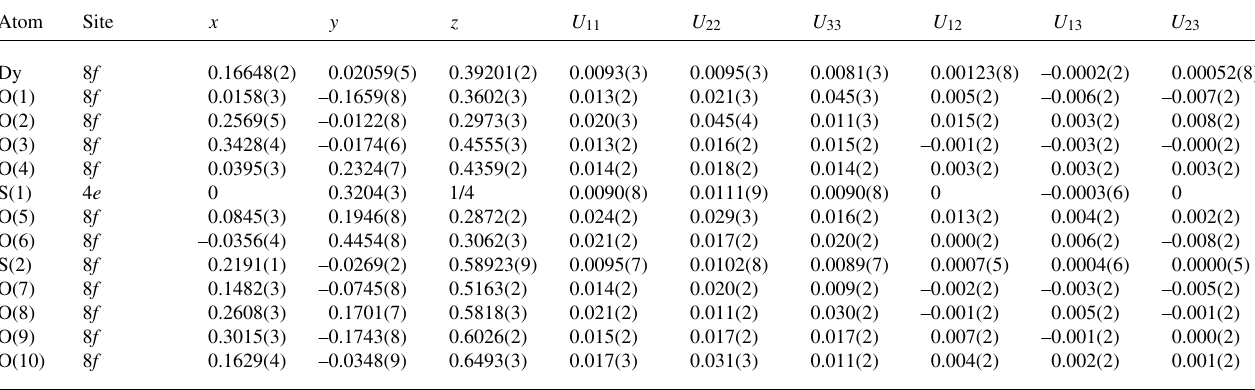
Table 6. Atomic coordinates and displacement parameters (in Å 2 ) .